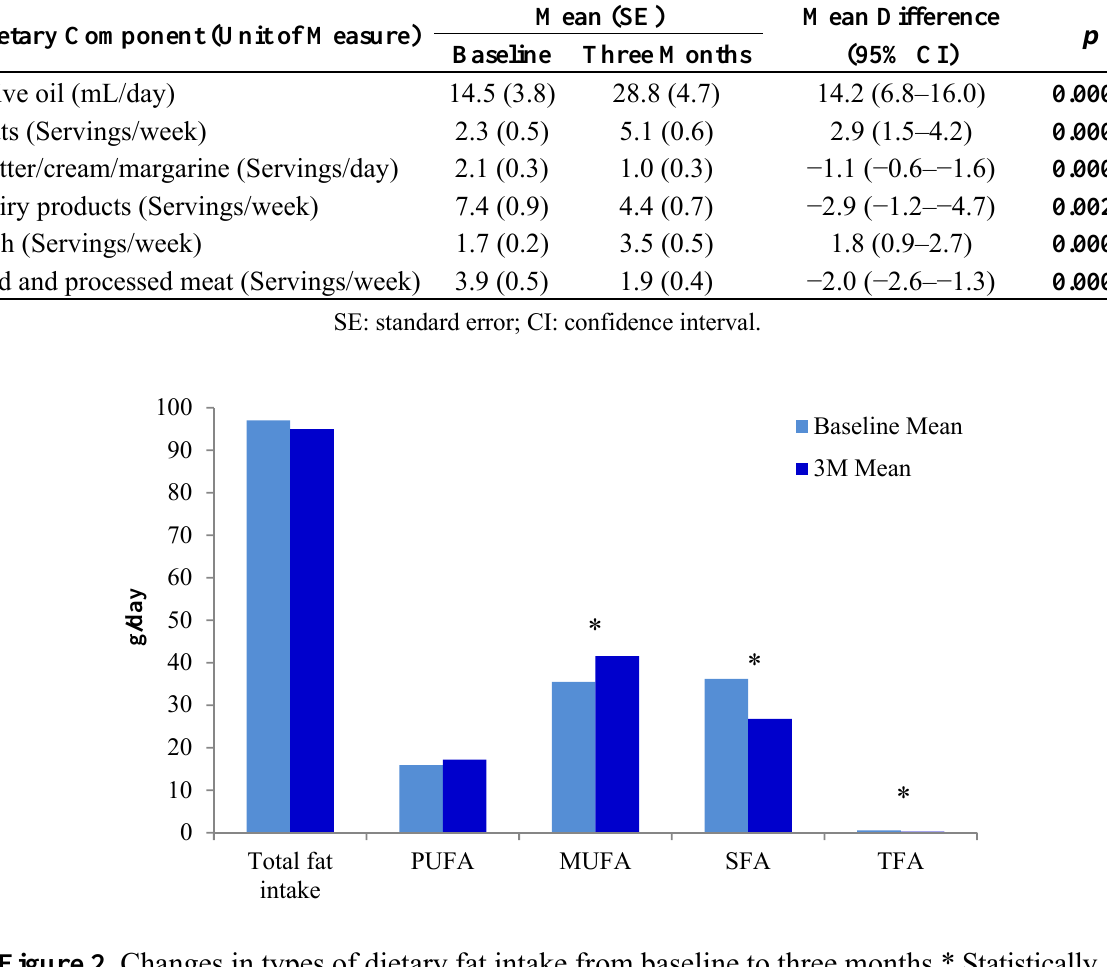
Figure 2. Changes in types of dietary fat intake from baseline to three months.* Statistically significant p values; PUFA: polyunsaturated fatty acids; MUFA: monounsaturated fatty acids; SFA: saturated fatty acids; TFA: trans fatty